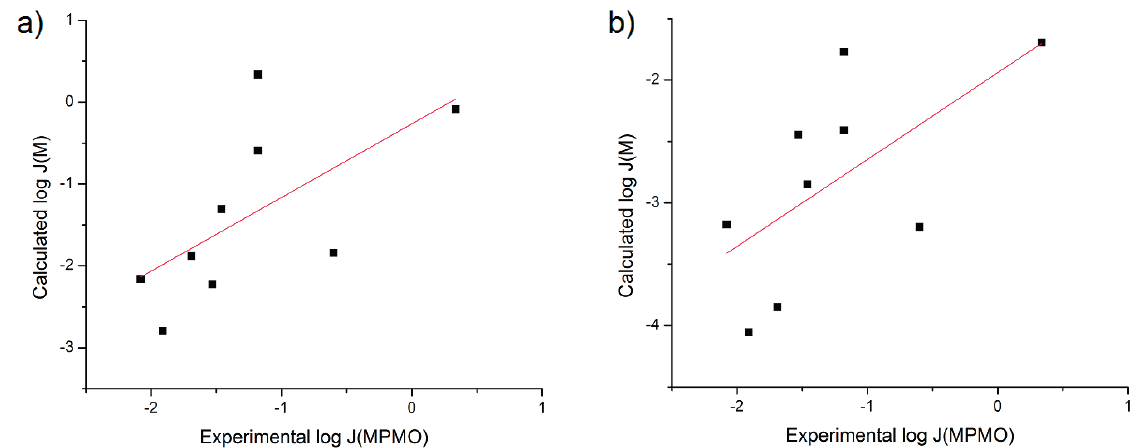
Figure 5. Plot of log J calculated with Stinchcomb et al. coefficients [5] versus Exp. log M using ( a ) S or ( b ) S . J MPMO 7.4 1.0